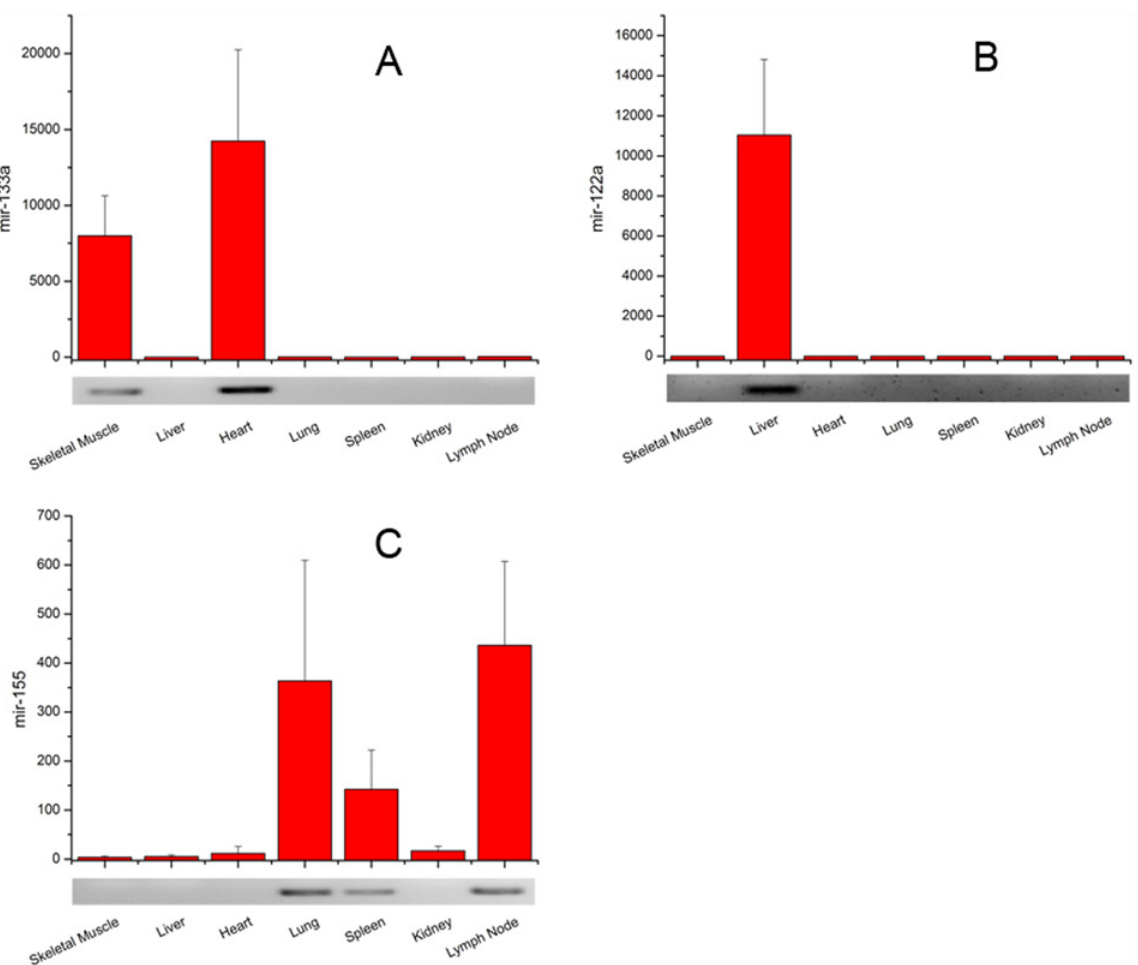
Fig 4. Quantification of miR-133a, miR-122a, and miR-155 expression in different tissues. A bar graph shows the normalized expression value detected by qPCR for each miRNA, and an autoradiogram shows the average signal of Northern blot for three repeated experiments. In the bar graph, the signal from nine tissues was normalized to the internal control of Met-tRNA. The background signal obtained from the sample containing H 2 O instead of RNA was set to zero.